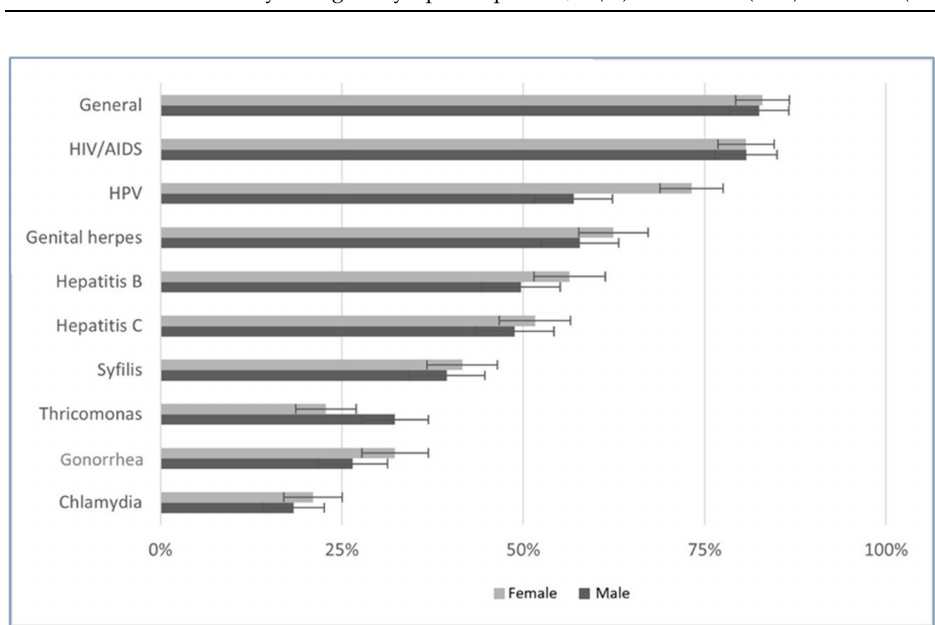
Figure 1. Adequate Knowledge about